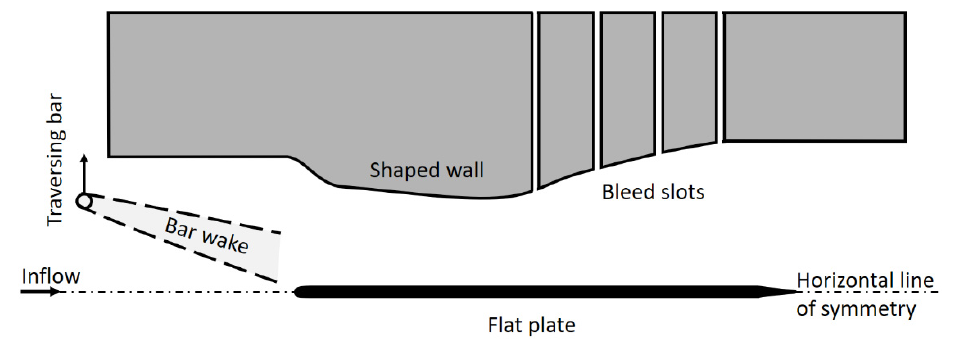
Figure 1. Schematic of the wind tunnel test section with the flat plate and the bar wake